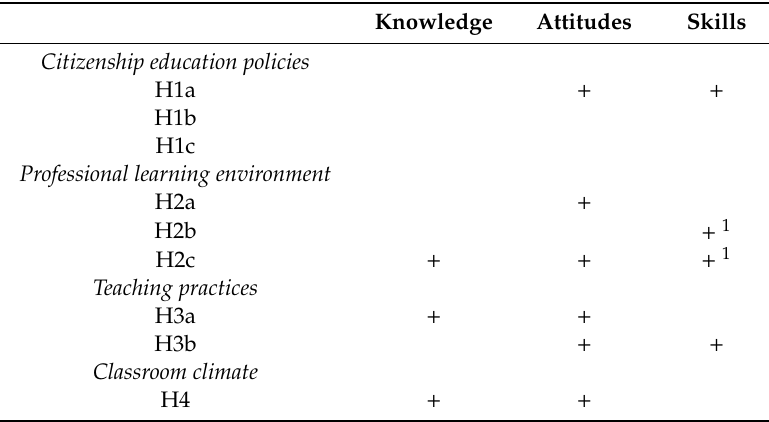
Table 6. Conclusions with regard to the formulated hypotheses. Knowledge Attitudes